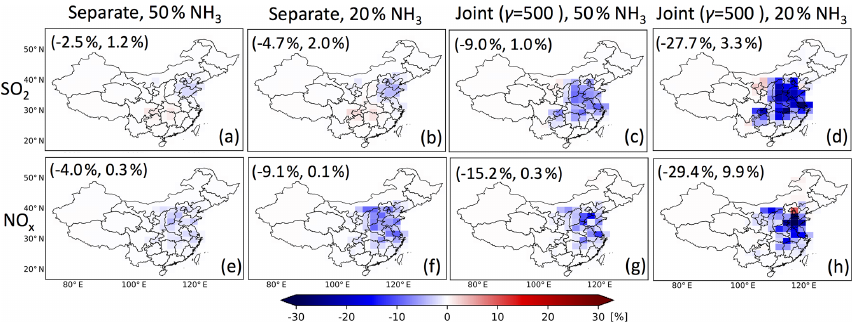
Figure 9. Relative changes in posterior SO 2 (a–d) and NO x (e–h) emissions from the scenarios of perturbing NH 3 emissions with respect to that using the original NH 3 emission inventory. Panels (a) and (b) show relative changes in posterior SO 2 emissions from E − SO 2 − 0 . 5NH 3 and E − SO 2 − 0 . 2NH 3 with respect to that from E − SO 2 , respectively. Panels (c) and (d) show relative changes in posterior SO 2 emissions from E-joint–0 . 5NH 3 - γ 500 and E-joint–0 . 2NH 3 − γ 500 with respect to that from E-joint–d γ ( γ = 500), respectively. Panels (e) and (f) show relative changes in posterior NO x emissions from E − NO 2 − 0 . 5NH 3 and E − NO 2 − 0 . 2NH 3 with respect to that from E − NO 2 , respectively. Panels (g) and (h) are similar to (c) and (d) , respectively, but for posterior NO x emissions. Minimum and maximum are shown in